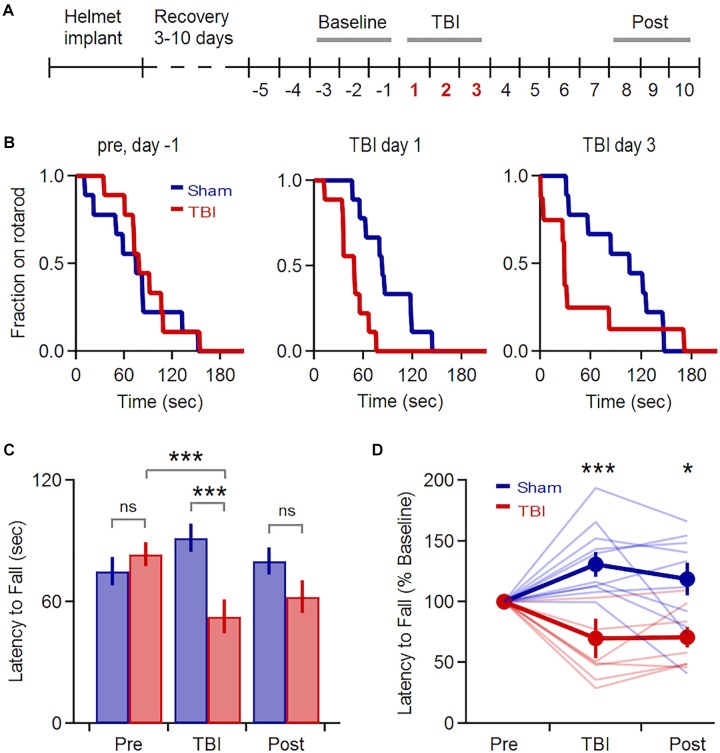
Transient Vestibulomotor Deficits after TBI. (A) Timeline of locomotor testing. Latency to fall was measured daily as indicated by numbers. (B) Fraction of mice remaining on the rotarod over time for testing 1 day before injury, as well as TBI days 1 and 3. Performance was similar for sham and TBI groups before injury, but was reduced on injury days (day 1: p = 0.019; k = 0.667; day 3: p = 0.034, k = 0.639; 2-sample K–S test; n = 9 sham, 8 TBI mice). (C) Mean latency to fall averaged over 3-day windows before, during, and after injury. Performance was decreased in TBI mice relative to pre-injury levels [85 ± 11 vs. 55 ± 13 s for baseline and injury days; p = 0.0002, t(23) = 4.394, paired t-test; n = 8 mice] and relative to the sham group during the injury period [92 ± 11 vs. 55 ± 13 s for sham and TBI; p = 0.002; t(49) = –3.242; 2-sample t-test; n = 9 sham, 8 TBI mice]. (D) Group data normalized to pre-injury baseline [injury phase: 131 ± 10% vs. 70 ± 16% for sham and TBI; p = 0.005; t(15) = 3.321; recovery phase: 118 ± 14% vs. 71 ± 9% for sham and TBI; p = 0.012; t(15) = 2.866; 2-sample t-test; n = 9 sham, 8 TBI mice]. ∗ and ∗∗∗ indicate p < 0.05 and p < 0.01.